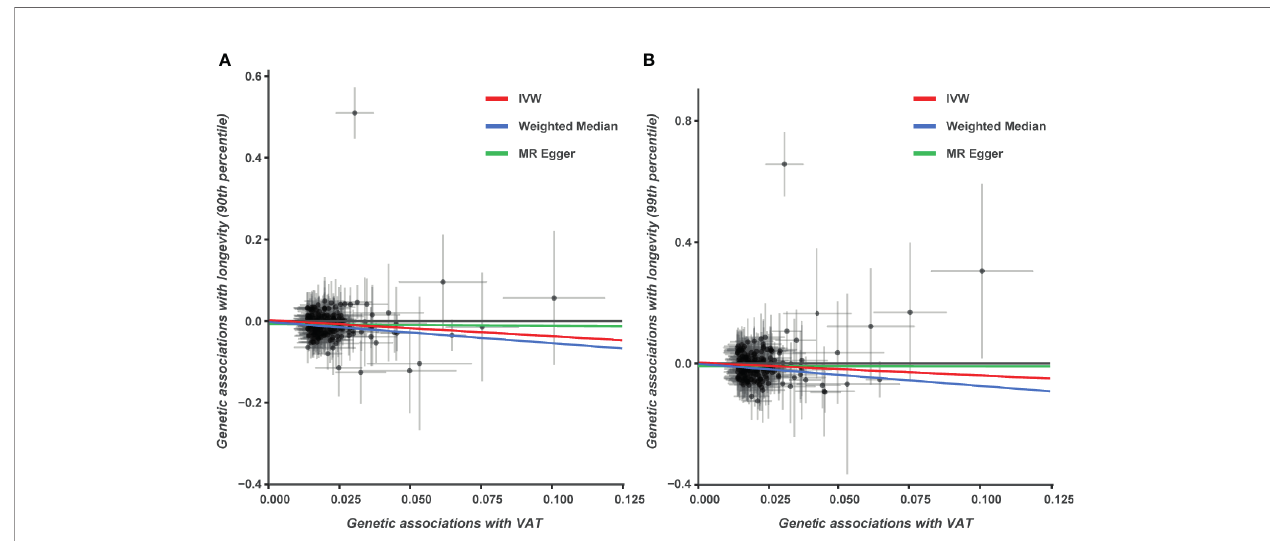
FIGURE 2 | Genetic associations between visceral adipose tissue (VAT) accumulation and longevity. (A) Genetic effect of VAT accumulation on survival to the 90th percentile age. (B) Genetic effect of VAT accumulation on survival to the 99th percentile